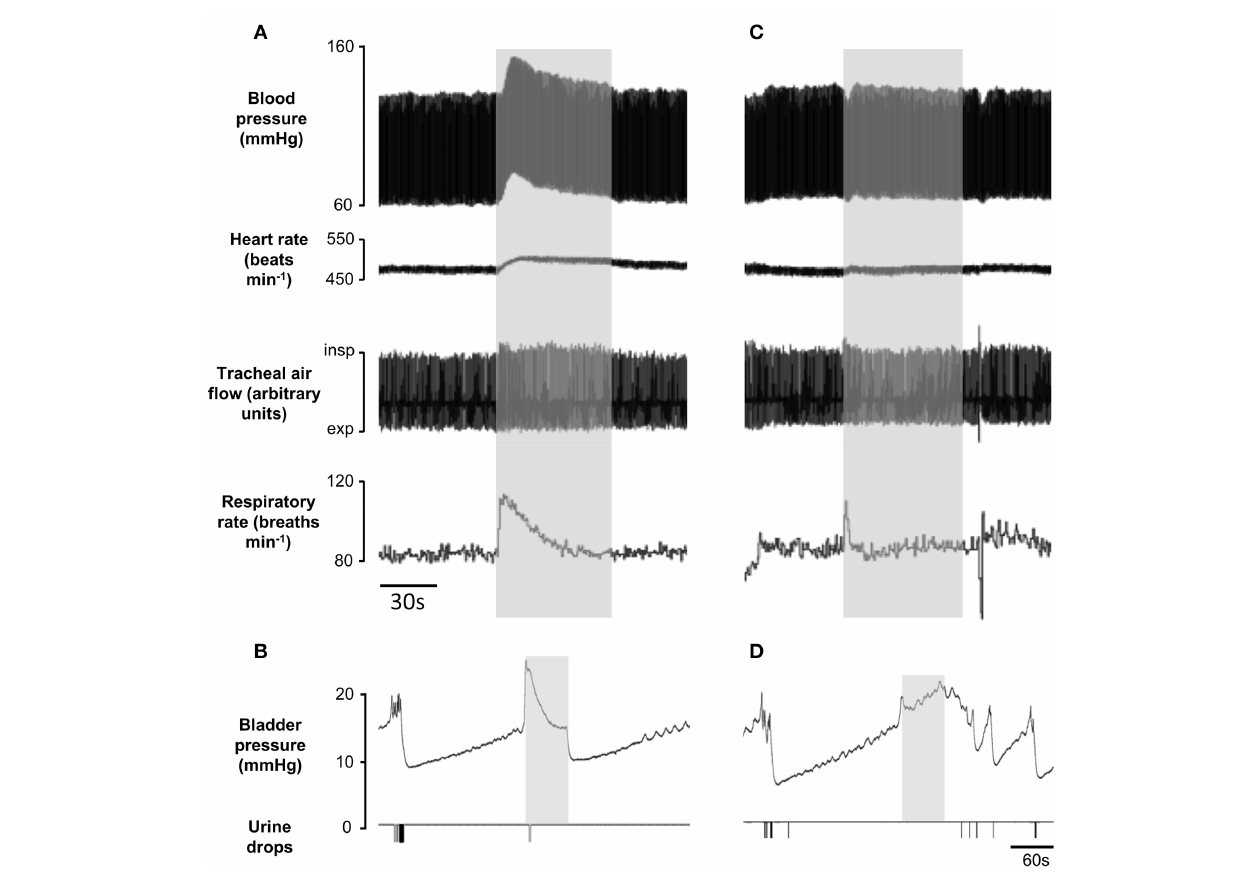
FIGURE 8 | Cardio-respiratory changes evoked by 1 min sinusoidal pelvic nerve stimulation. (A,B) stimulation using suboptimal parameters (500 Hz) evoked cardiorespiratory changes and incomplete inhibition of voiding. (C,D) stimulation at higher frequency (3 kHz) in the same rat was without effect on blood pressure and heart rate whilst voiding was inhibited